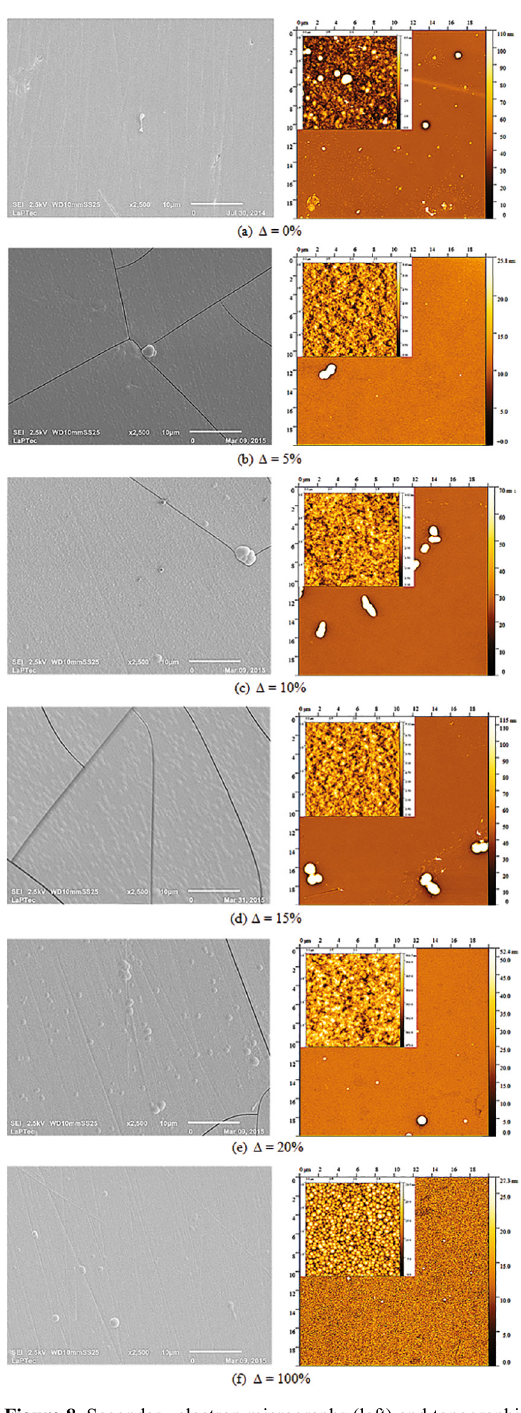
Figure 8. Secondary electron micrographs (left) and topographic profiles (right and insert) for the films deposited using bias signals with duty cycles between 0 and 100%.